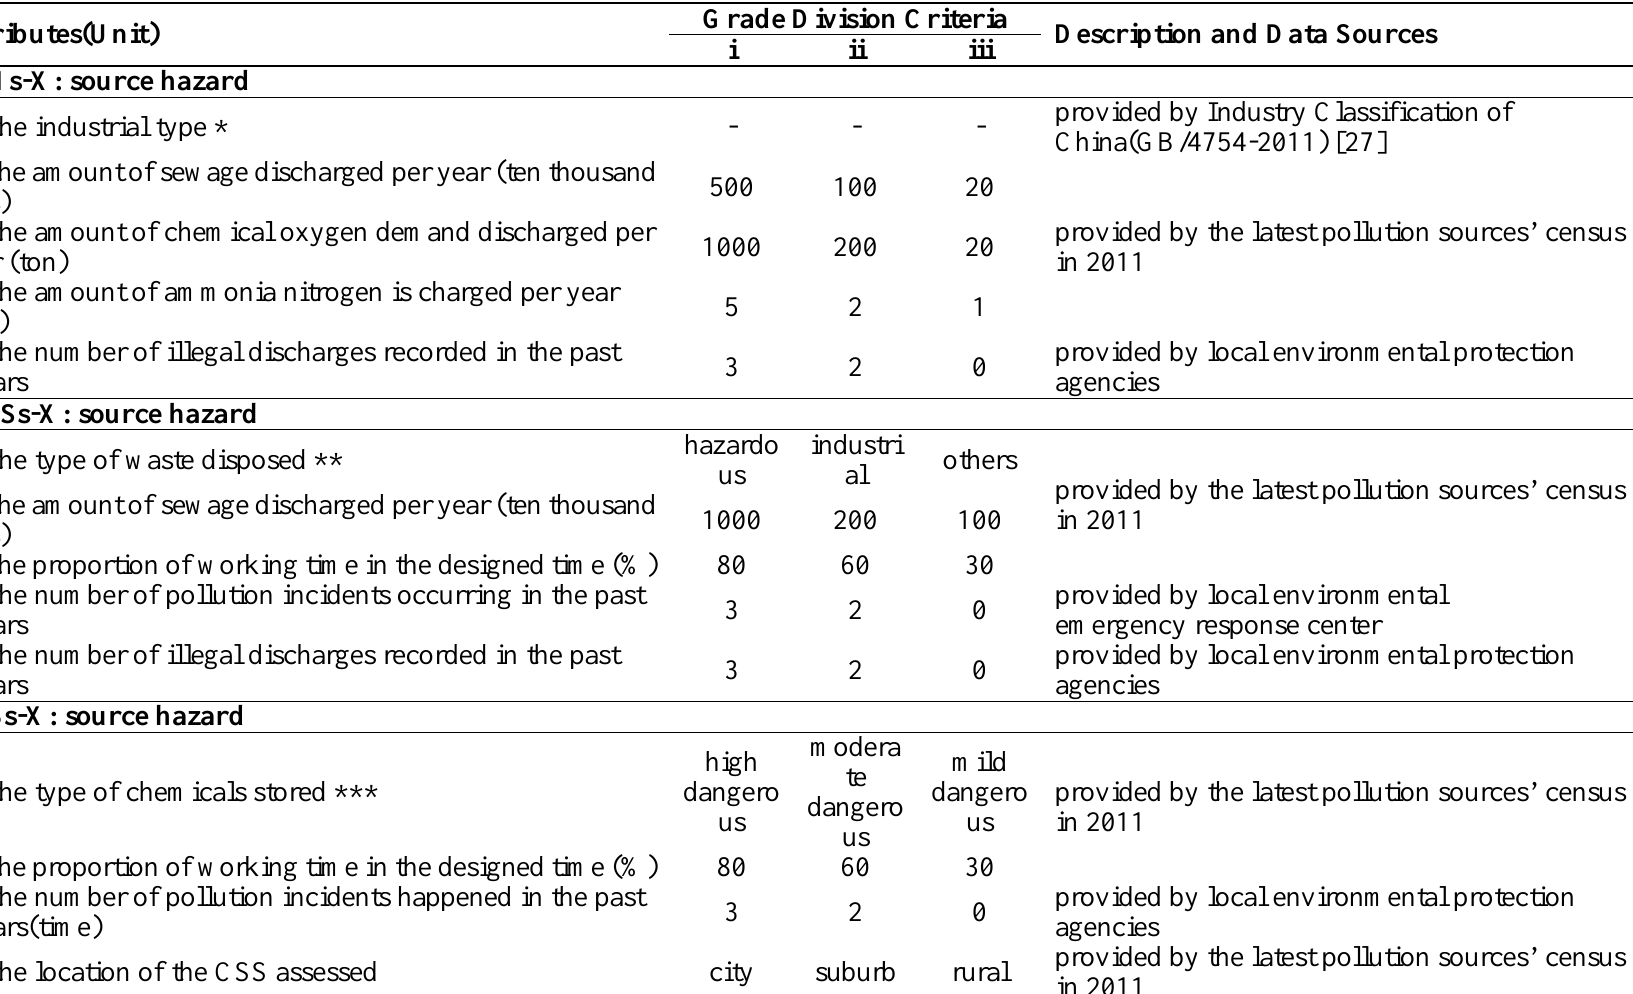
Table 1. Attributes of risk levels of PENs, WDSs, CSSs and their grade division